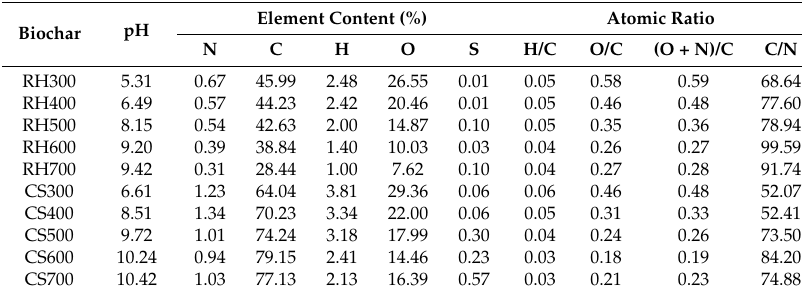
Table 2. Biochar pH and elemental composition of the biochar materials obtained at various pyrolysis temperatures.